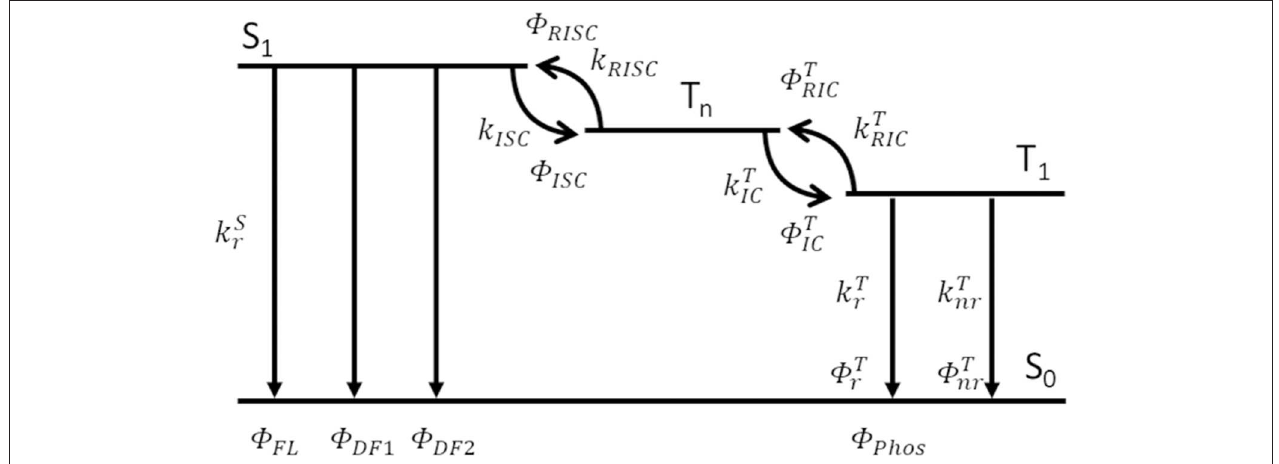
FIGURE 5 | Kinetic analysis model of TADF with four states.